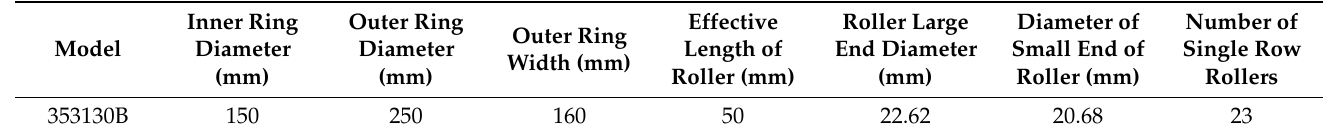
Table 1. Structural parameters of railway bearing 353130B.